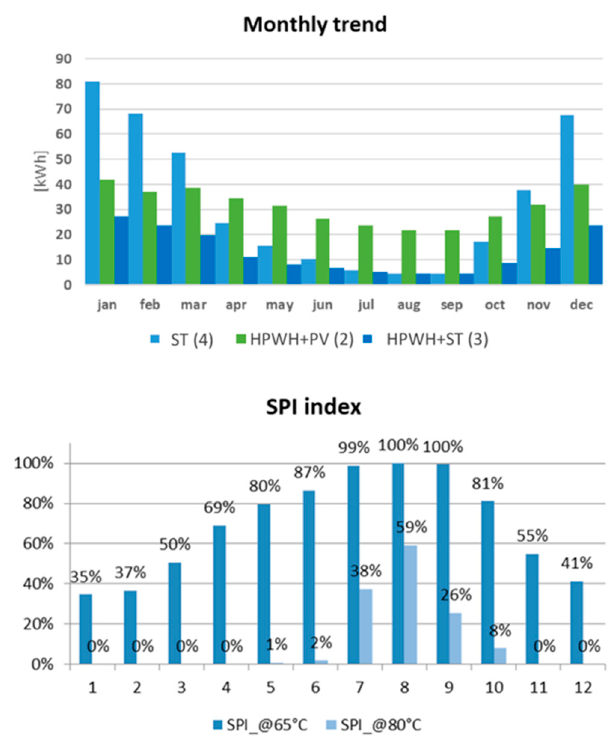
Figure 17. Top : electrical consumption of the systems; bottom : monthly setpoint index Figure 17. Top: electrical consumption of the systems; bottom: monthly setpoint index (SPI).